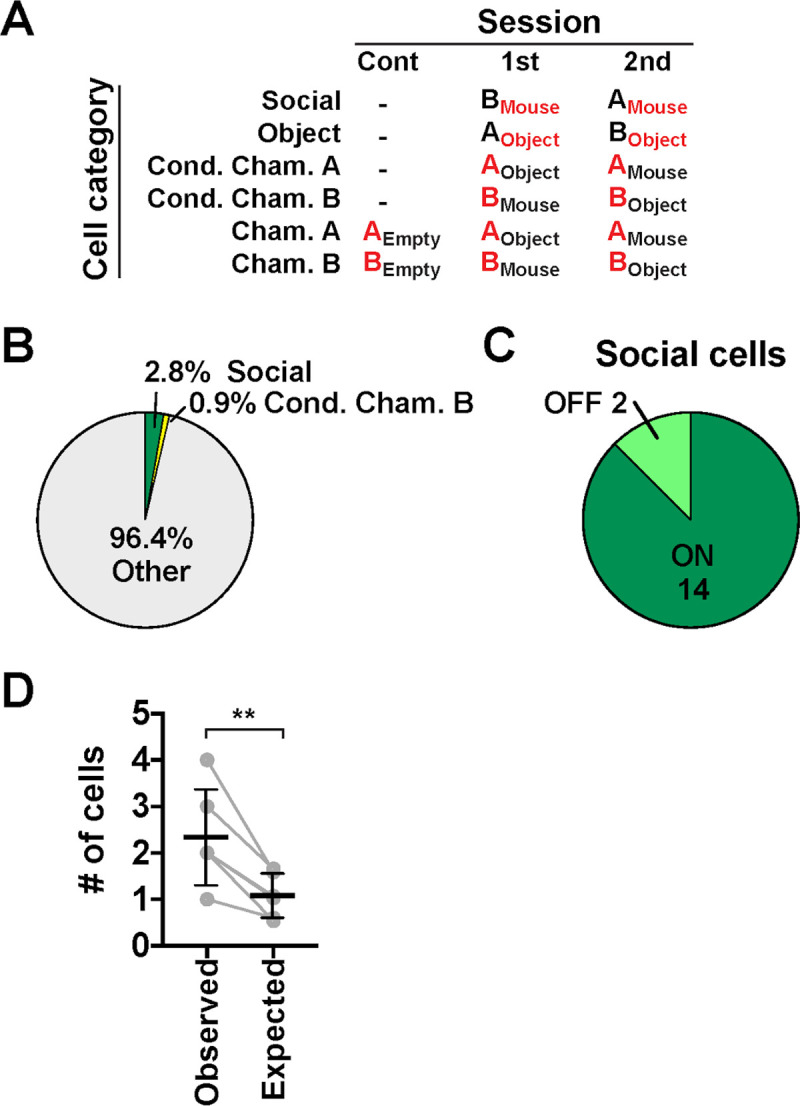
Social cells and other cell categories in LC experiments.(A) Definition of each category of cells and their preference for stimulus–chamber relationship. “A” and “B” represent chamber A and chamber B, respectively. Their contents are indicated by the subscript to represent stimulus–chamber relationship. The features each cell category preferentially responds to are shown in red. (B) A pie chart that shows the fractions of each cell category within the total cell population (n = 580 cells from 6 mice). “Other” includes very small fractions of chamber A cells (0.3%), conditional chamber A cells (0.2%), and object cells (0.2%). (C) A pie chart showing the fractions of “ON” cells and “OFF” cells within total social cells. Numbers represent absolute cell numbers. (D) The number of consistent Social-ON cells observed (“Observed”) and that expected from the fraction of cells in each session (“Expected”) (mean ± SD; P = 0.0063, observed versus expected, t(5) = 4.52, paired t test, n = 6 mice; S1 Data, sheet Fig 4D). LC, linear chamber.